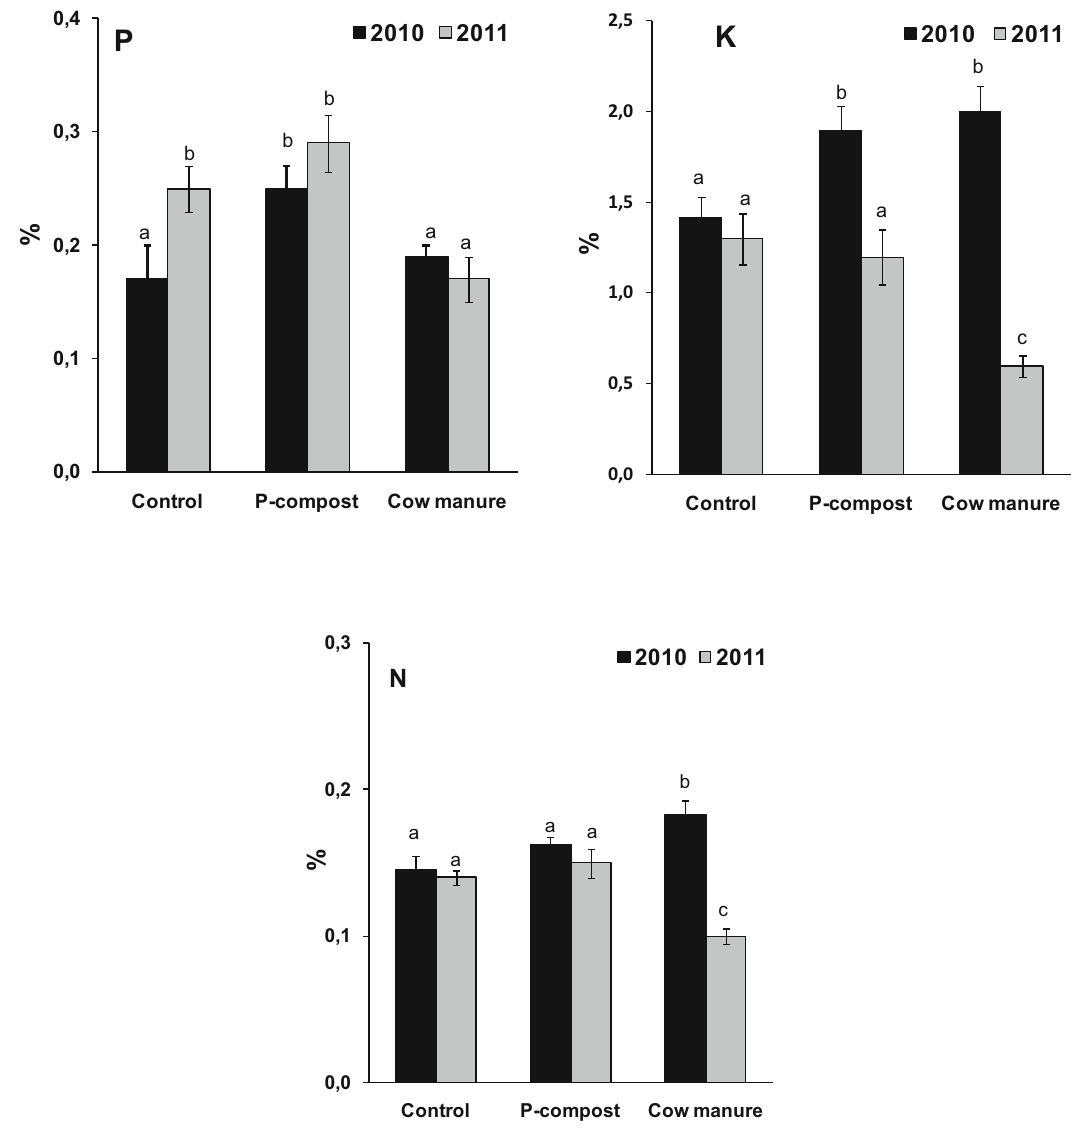
Fig. 2 Phosphorus (P), potassium (K) and nitrogen (N) uptake in alfalfa according to the different fertilization treatments. Values with different letters are statistically according to a Dunnett’s test at P =